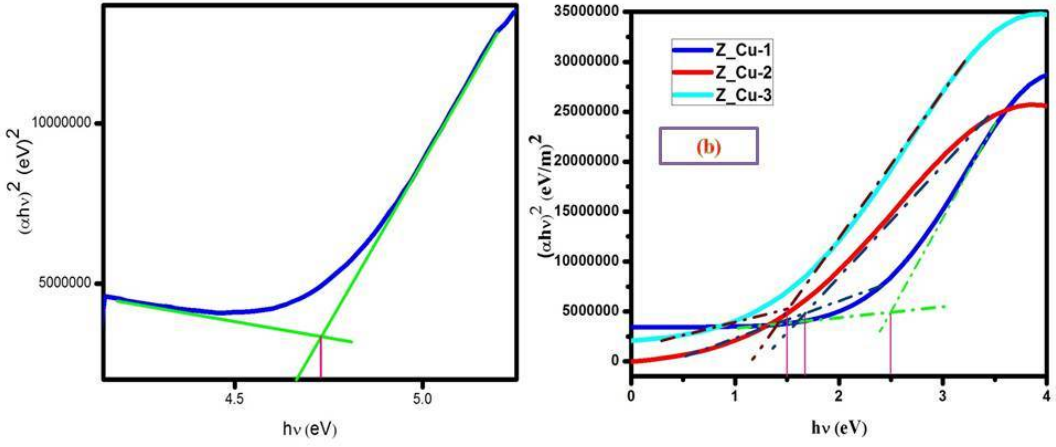
Fig. 5. Tauc plots for (a) pure and (b) Cu doped ZrO